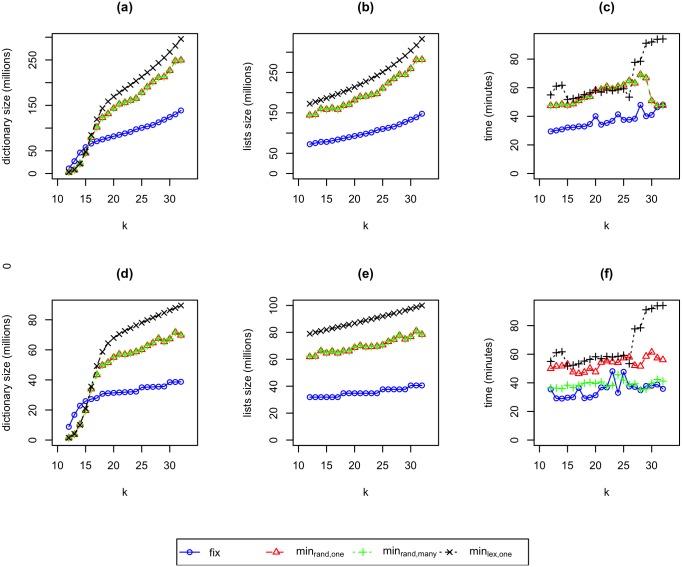
The dictionary sizes, lists sizes, and construction times for k-mer indexes built using fixed sampling (fix) and minimizer sampling minrand,one, minrand,many, and minlex,one.For parts (a), (b), and (c), we use L = 50. For parts (d), (e), and (f), we use L = 100. For all graphs, 12 ≤ k ≤ 32.